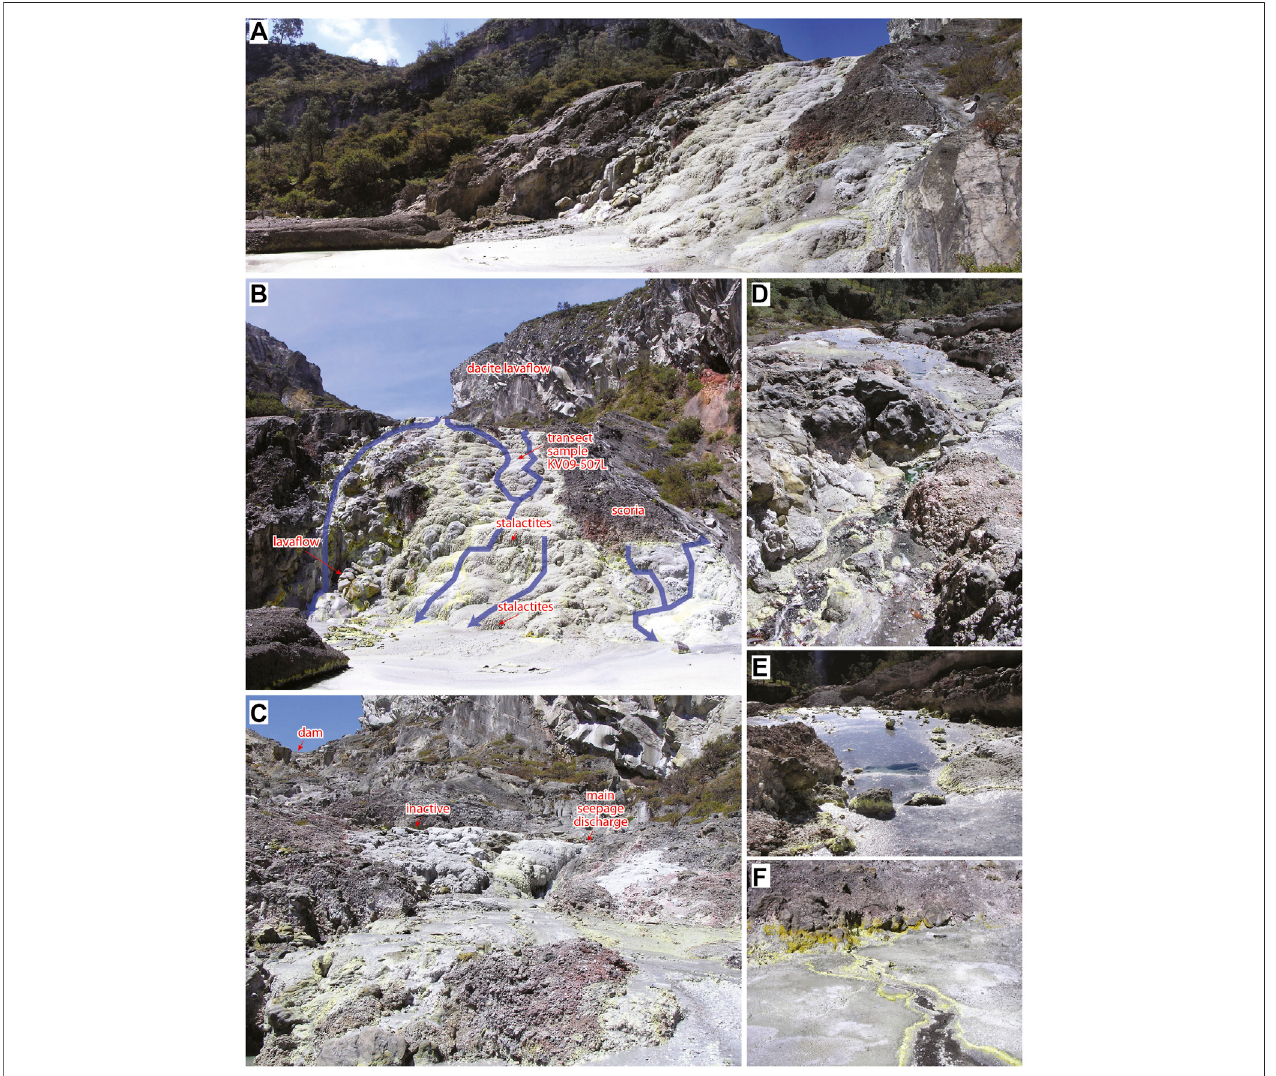
FIGURE2| Overviewphotographs ofthegypsumplateau. (A,B) .Viewoftheplateau lookingapproximately north-eastandeast, respectively,showingits stepped cascadeshape.Gypsumstalactitesgrowfromtheoverhangsofthesteps.Themain fl owovertheplateauisontheleft,alongtheexposedlava fl ow,therightcenter,over the samplesite, and from aspringonthe rightthathas produced thegypsum startingabout two-thirds down theface ontheright. (C) . Viewoftheuppermostsection of theplateau(notvisibleina,b).Themainseepagespringisontherightinthisimageandformsachannelwithsubsequentspreadingoutofwateroverthe fl atsection of gypsum in the foreground. The white, fractured crusts of gypsum on the left represent an inactive section of the plateau. (D) . View towards the west from the main seepage spring above the plateau. Only small amounts of gypsum precipitate at the seepage outlets and the water fl ows on sediment instead. (E) . View of the top, fl at part of the gypsum plateau looking west showing the thin fi lm of water that covers the gypsum. (F) . Channel of seepage water with yellow (Na,K)-alum precipitates on either side, resulting from evaporation of spray.